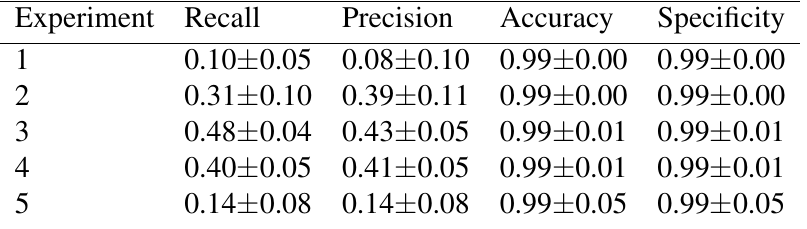
Table 2: Efficiency of our method at 4 ˚A of distance threshold ( (cid:22) (cid:6) (cid:27) values).